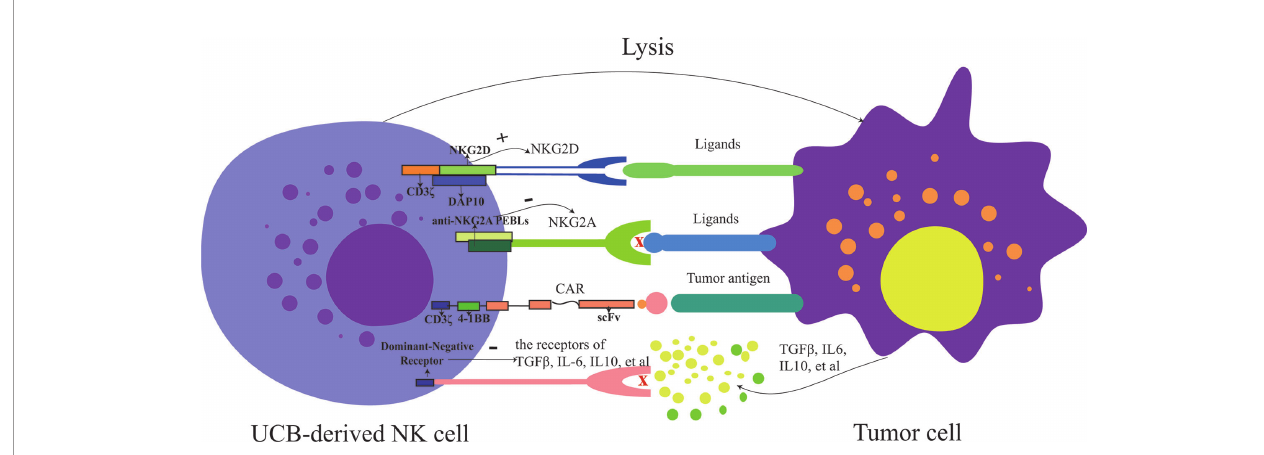
FIGURE 1 | The strategies for modifying UCB-derived NK cells include enhancing activation (such as: increase the expression of activating receptor: NKG2D and decrease the expression of inhibitory receptor: NKG2A), targeting tumor antigen and overcoming the immunosuppressive tumor microenvironment (such as IL-6, IL- 10, and TGF b ). PEBLs, anti-NKG2A protein expression blockers; CAR, chimeric antigen receptor; UCB, umbilical cord blood; NK cells, natural killer